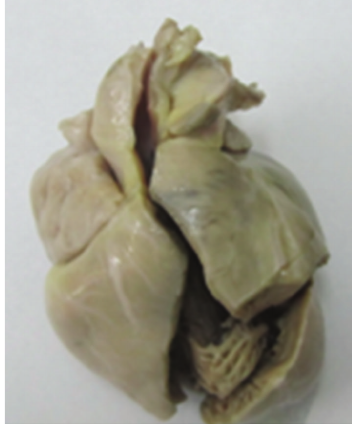
Figure 3: Macroscopic view of the heart at